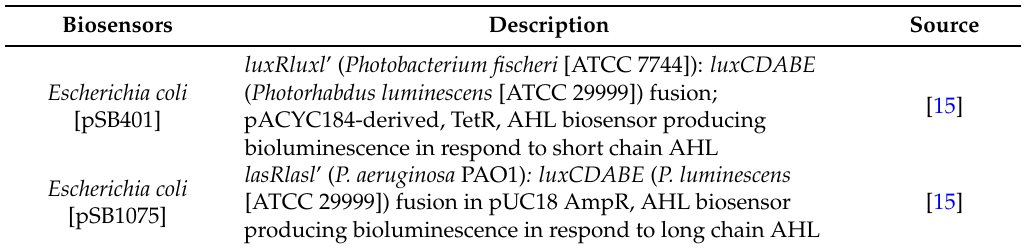
Table 1. List of biosensors